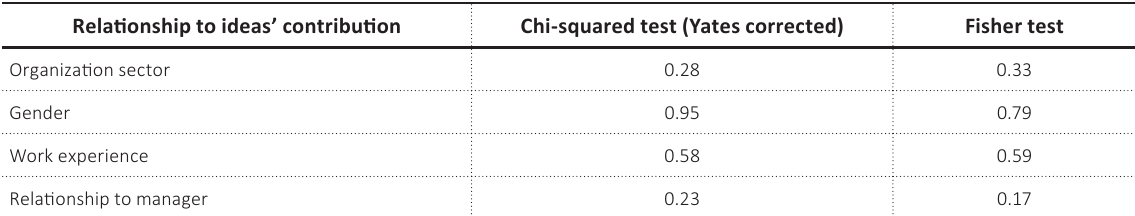
Table 8. Effect of gender, work experience, organization sector, and relationship with managers on the idea’s contribution ( p